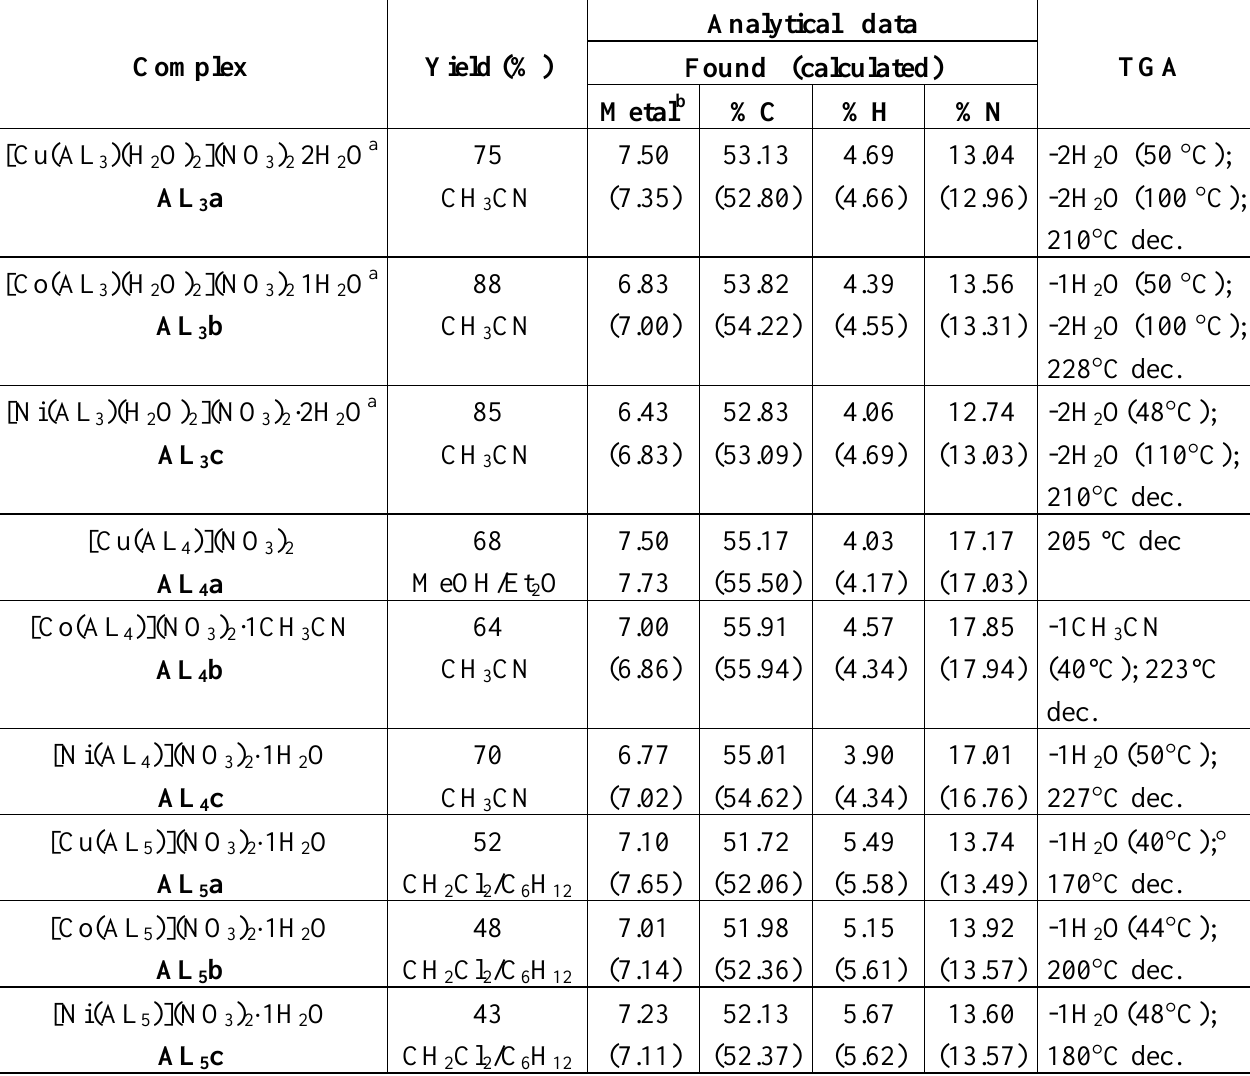
Table III. Analytical and TGA data for the